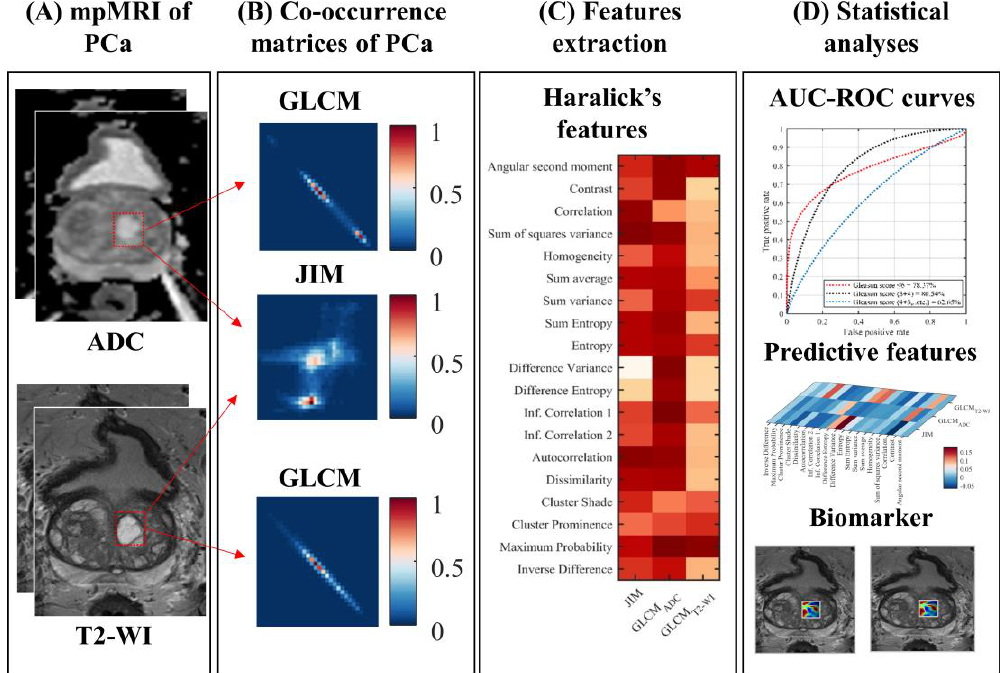
Figure 1. Schema of the utilized methodology for a GS prediction model for prostate cancer. ( A ) T2-WI and ADC MRI images of 99 patients with biopsy-confirmed and MRI-localized PCa are extracted; ( B ) Co-occurrence matrices (i.e., JIM and GLCMs) were computed from ROI’s which corresponded to biopsy-proven sites of PCa; ( C ) The 19 features encoded within the GLCMs and JIM are extracted; ( D ) Statistical analyses performed uni- and multivariate analyses of these features to generate a model predictive of the GS.